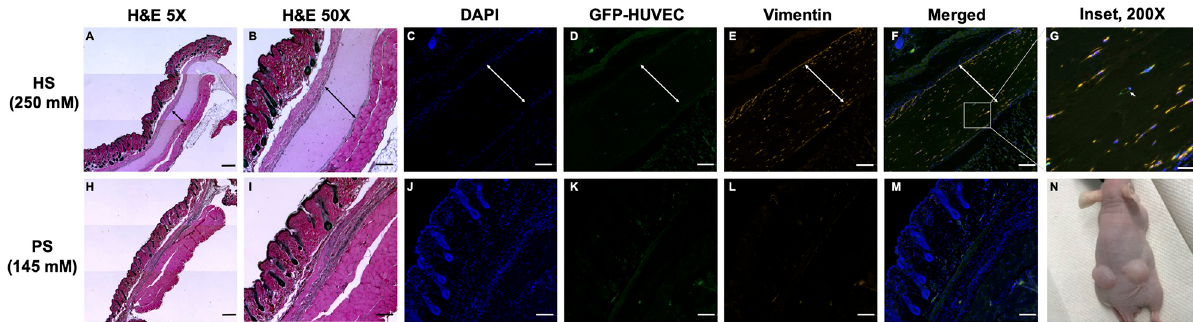
Fig 5. HS gels are stable in vivo after 7d, but PS gels degraded completely. HS and PS precursor solutions were mixed with GFP-HUVEC (green) and HDF (stained with Vimentin, red) and injected subcutaneously into athymic mice (N). After 7d, HS gels remained intact (H&E, A and B) and delivered cells remained viable (IF, C-G). Remaining gel indicated with arrows. PS gels degraded completely; no gel or delivered cells were detectable after 7d (H-M). Scale bars 500um (A, H), 200um (B-M), 50um